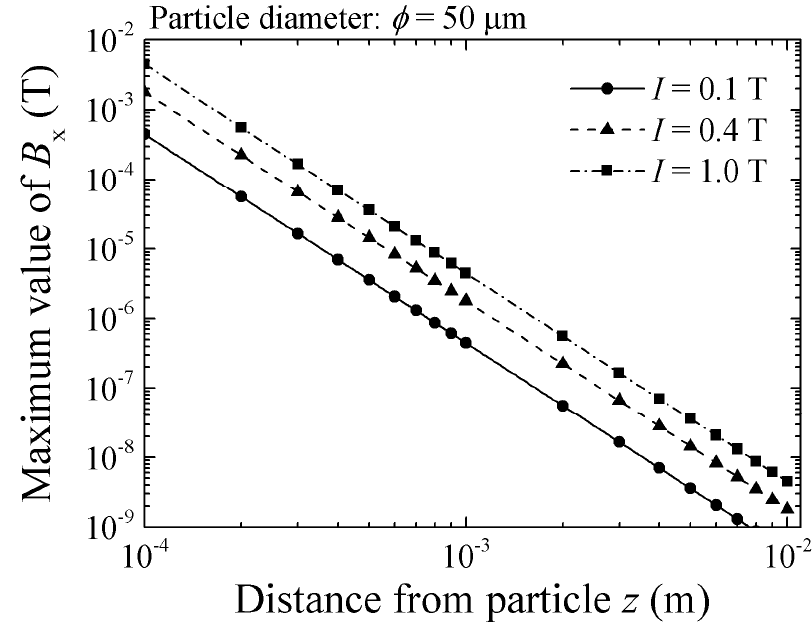
Figure 4. Simulated variation of flux density, B x , as a function of particle height, z , in case of particle diameter 50 µ m [21].